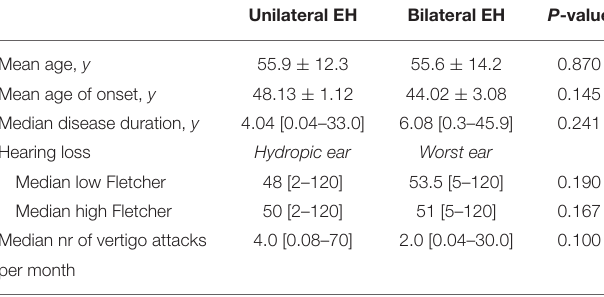
TABLE 6 | Clinical differences between unilateral and bilateral HED patients. TABLE 7 | Characteristics of unilateral HED patients with and without drop